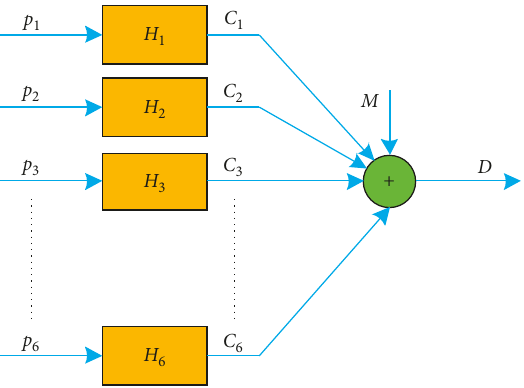
Figure 17: The combustion noise calculation model.